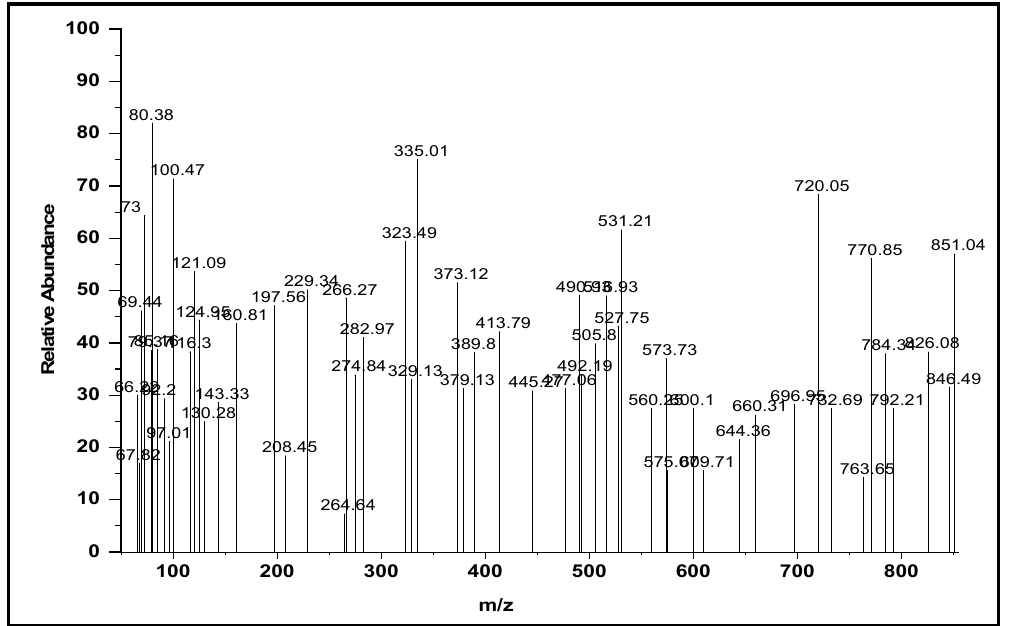
Figure 4. The mass spectrum of the Hg(II) complexes.